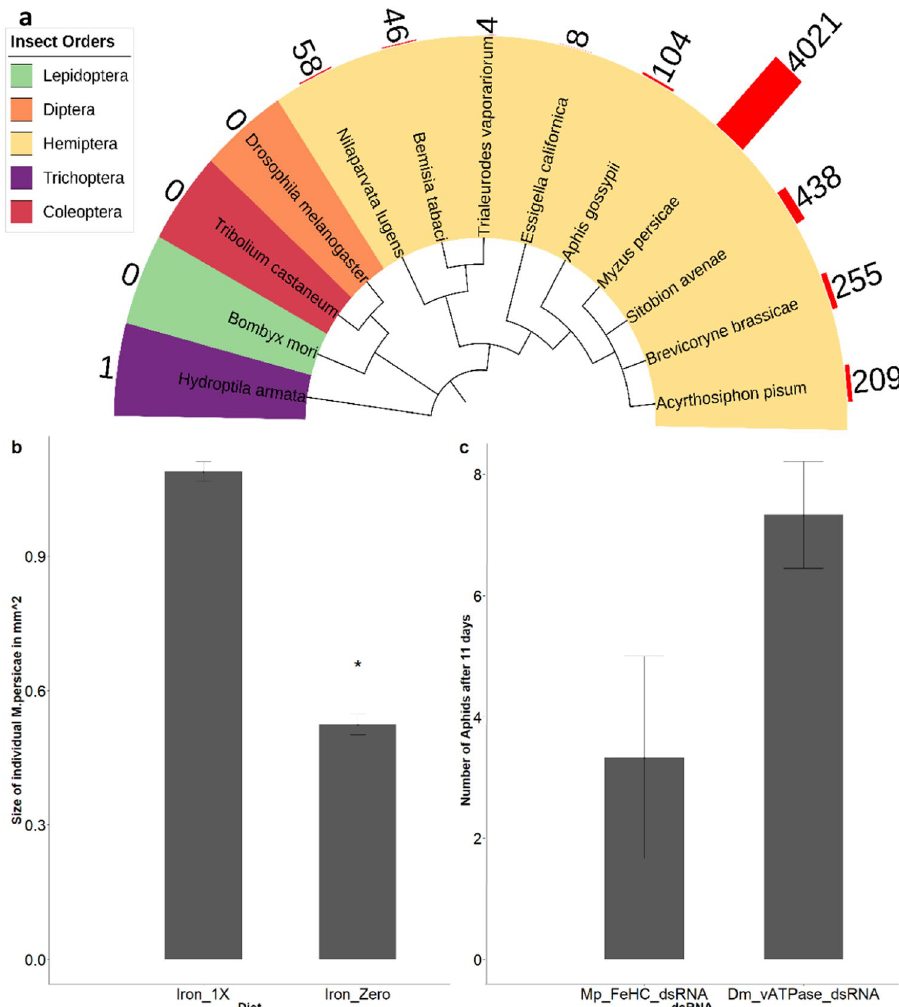
Figure 4. Ferritin satisfies the criteria as a good target gene for RNAi yet Mp_FeHC_dsRNA fed to M . persicae in artificial diet does not affect target gene activity or aphid number. ( a ) A histogram bar representing the number of 21mers matches to the 495nt of the Mp_FeHC gene is shown for each insect around the perimeter of the species tree cladogram (drawn based on Cytochrome oxidase I). ( b ) Dietary iron deficiency reduces aphid size (Student t-test, replicates = 3, p = 0.0001). Asterisks indicate significant differences in M . persicae size. ( c ) Mp_FeHC_dsRNA does not significantly affect newly born aphid numbers after 11 days of feeding relative to treatment with Dm_vATPase_dsRNA from Drosophila melanogaster . The error bars represent the standard error of the